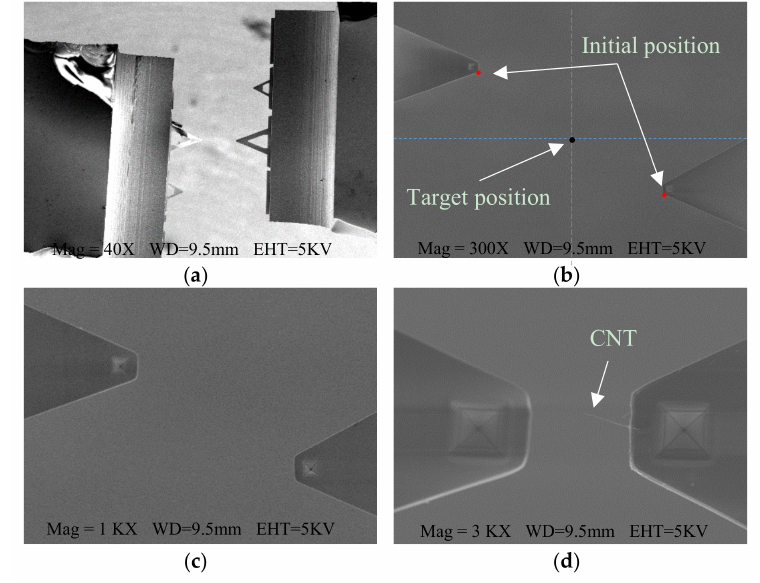
Figure 7. Demonstration of the automated centering procedure of both AFM cantilevers. ( a ) Bringing both AFM cantilevers into the FOV under low magnification; ( b ) Increasing SEM magnification until only the cantilevers’ distal parts can be seen, to start the automated operation; ( c ) Moving the end-effectors to the FOV center for further enlargement; ( d ) The soldered CNT can be detected at an image magnification of 3000 ×